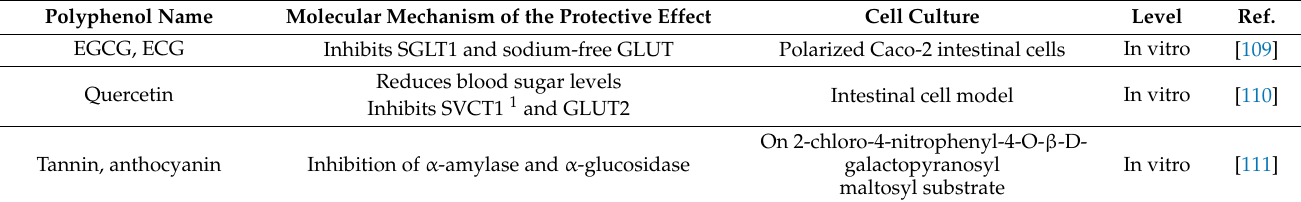
Table 12. Effect of the polyphenol content of grape marc (grape seeds and skins) on